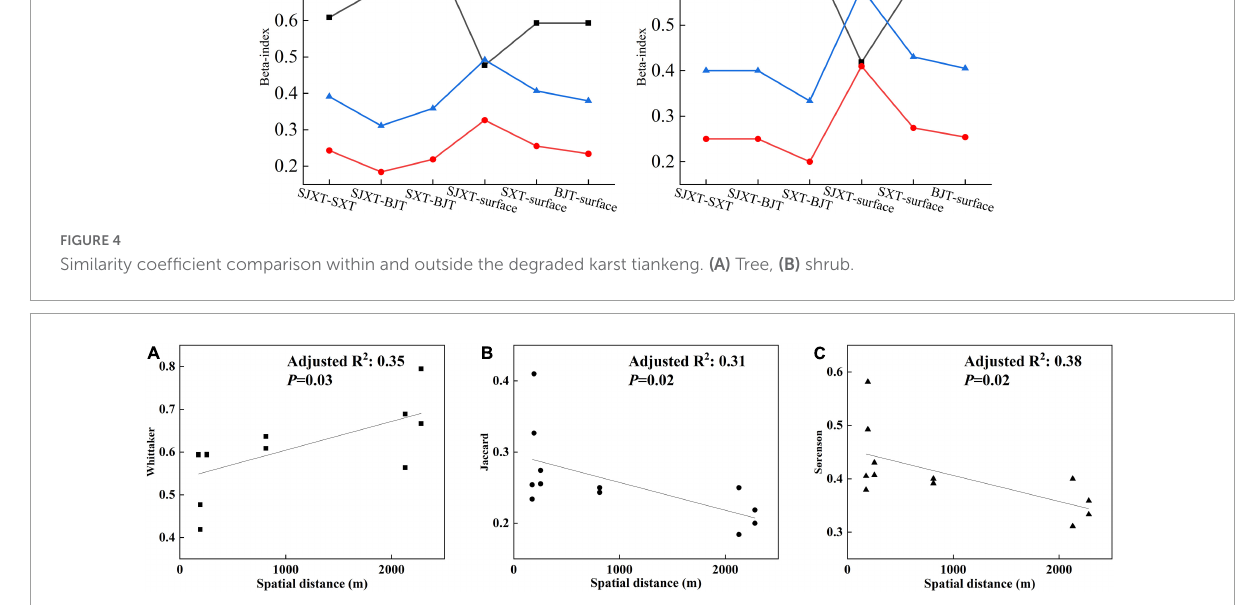
FIGURE5 Relationship between flora beta-diversity and spatial distance of environmental gradients, within and outside the degraded karst tiankengs and between karst tiankeng groups in Yunnan, China. (A–C) Refer to the relationships between Jaccard, Sørenson, Whittaker and spatial distances, respectively. Black line is the best-fit linear regression